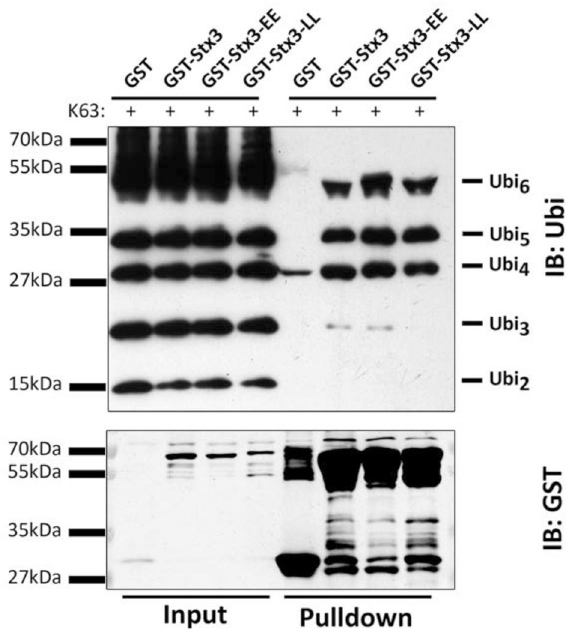
Figure 5. Binding mutant Stx3 to K63-linked polyubiquitin chains. Purified GST fusion protein of the wild- type Stx3 cytoplasmic region (1–265) or of mutants containing either L77A/L80A (LL) or E78A/E83A (EE) mutations were incubated with K63-linked polyubiquitin chains (1–7 ubiquitin molecules in length) followed by glutathione sepharose pull-down and probed with anti-ubiquitin and anti-GST antibodies. Experiment shown is representative of three independent